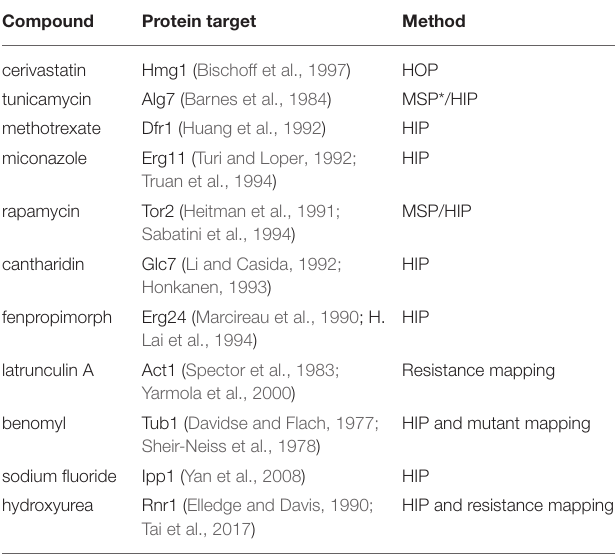
TABLE 1 | Compounds used and known